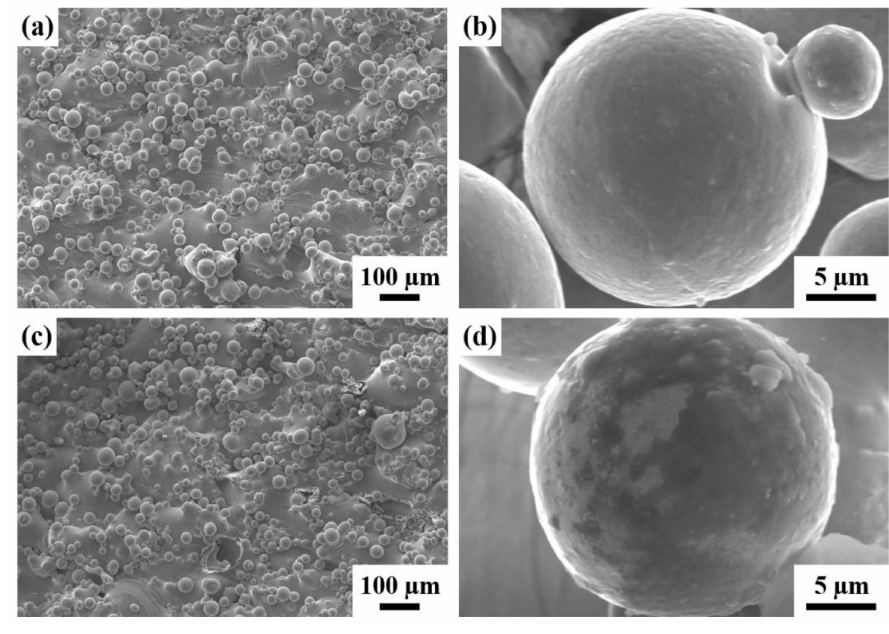
Figure 1. The SEM surface morphology for ( a , b ) NAP and ( c , d ) AP samples.